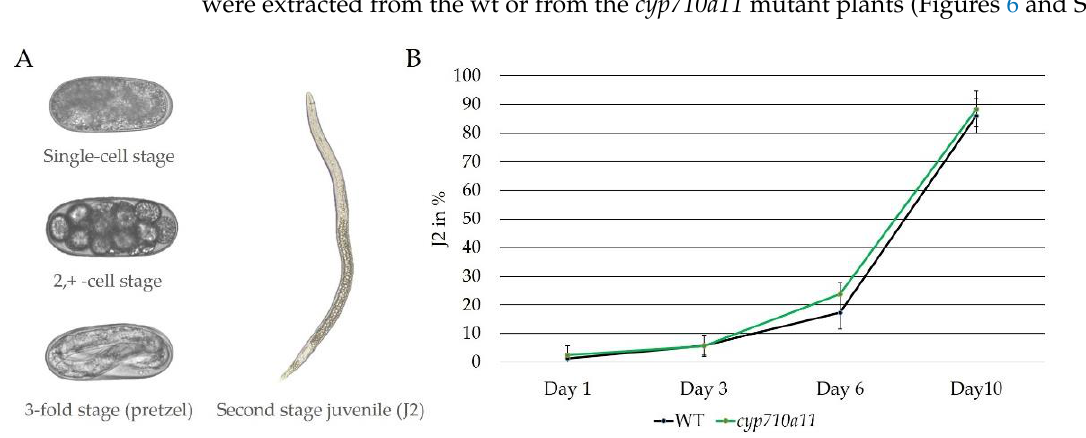
Figure 6. M. incognita development from an egg to second-stage juvenile (J2), extracted from the wt cv. Micro-Tom or cyp710a11 mutant tomato plants. The egg development was recorded over 10 days (Figure S2). The single-cell stage, 2, + − cell stage, 3-fold stage (pretzel stage) and second stage juvenile (J2) were counted ( A ). The development of the J2 stage on days 1, 3, 6 and 10 is presented as the percentage of J2 in the total egg count ( B ). n = 6 biological replicates. No significant differences were recorded using a two-tailed Student’s t -test.